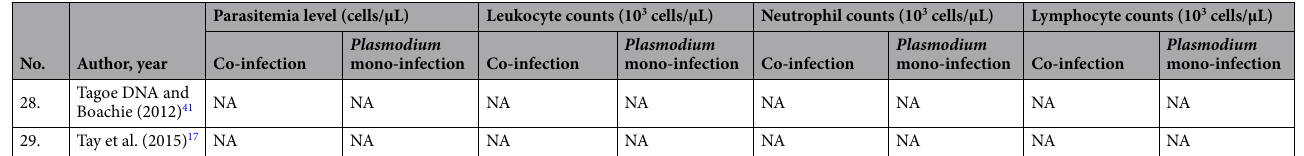
Table 2. Parasitemia level and leukocyte differential counts in co-infections and Plasmodium mono- infections. NA not